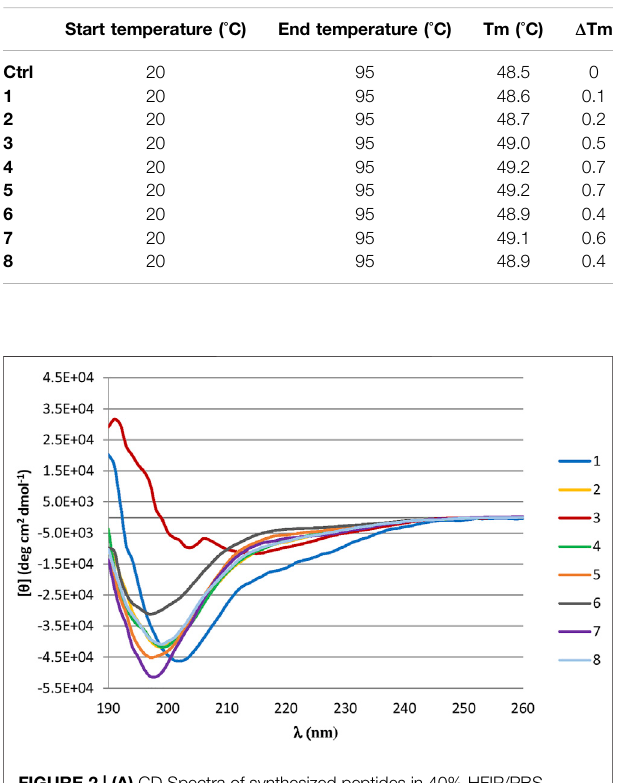
FIGURE 2 | (A) CD Spectra of synthesized peptides in 40% HFIP/PBS solution. Peptides are represented in: 1 (blue line), 2 (yellow line), 3 (red line), 4 (green line), 5 (orange line), 6 (grey line), 7 (purple line), 8 (light blue